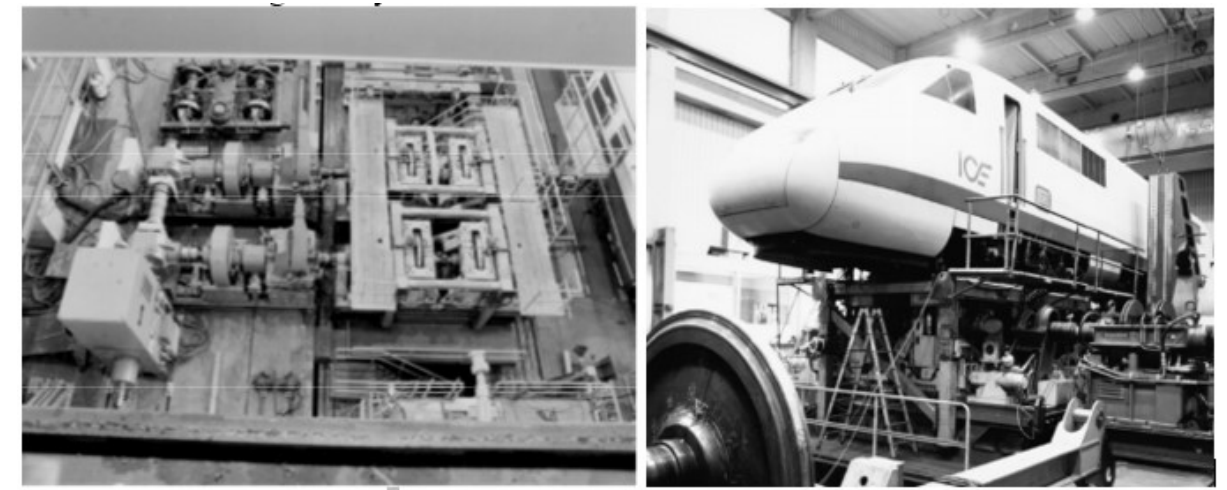
Figure 3. The roller rig built by DB-AG in Munich [1, 2].